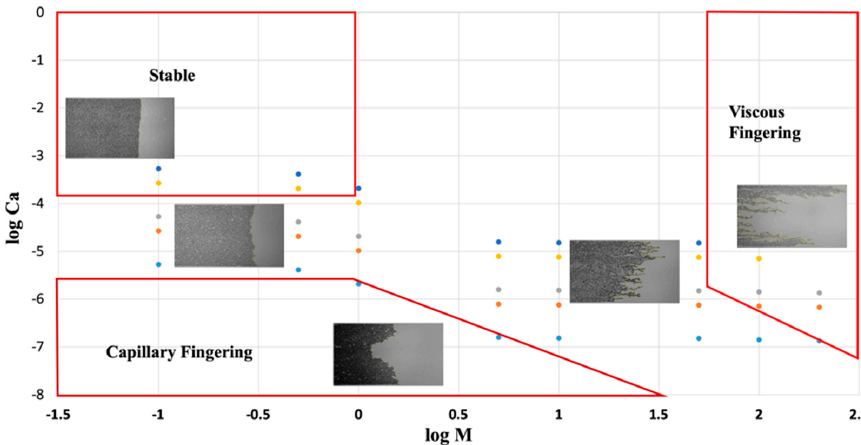
Figure 10. Imbibition flow phase diagram with boundaries of three flow regimes (red boxes).